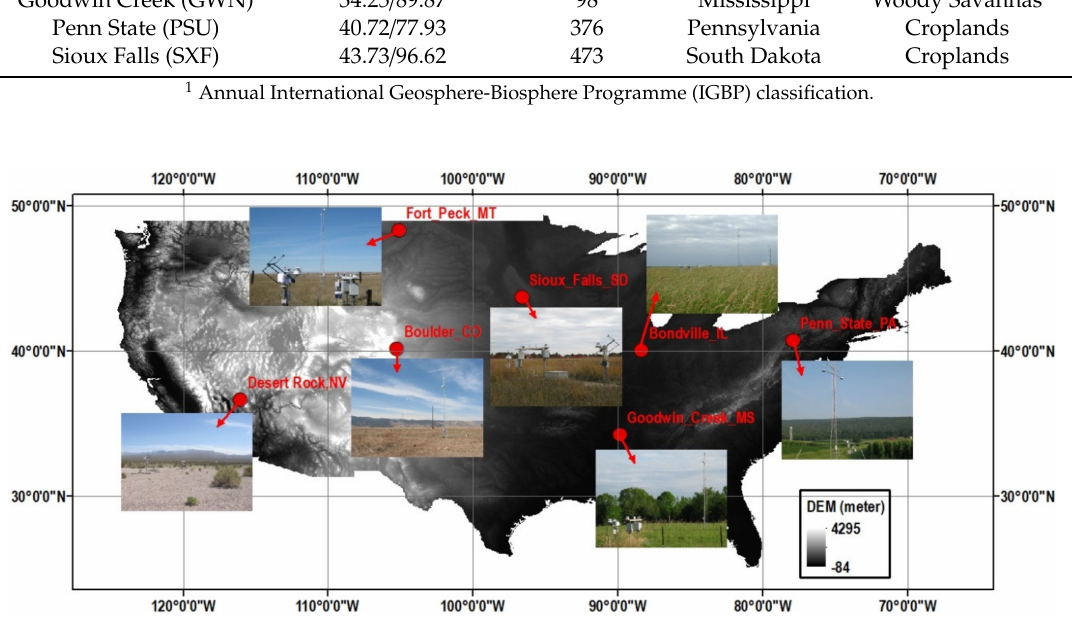
Figure 1. Seven SURFRAD stations and the corresponding